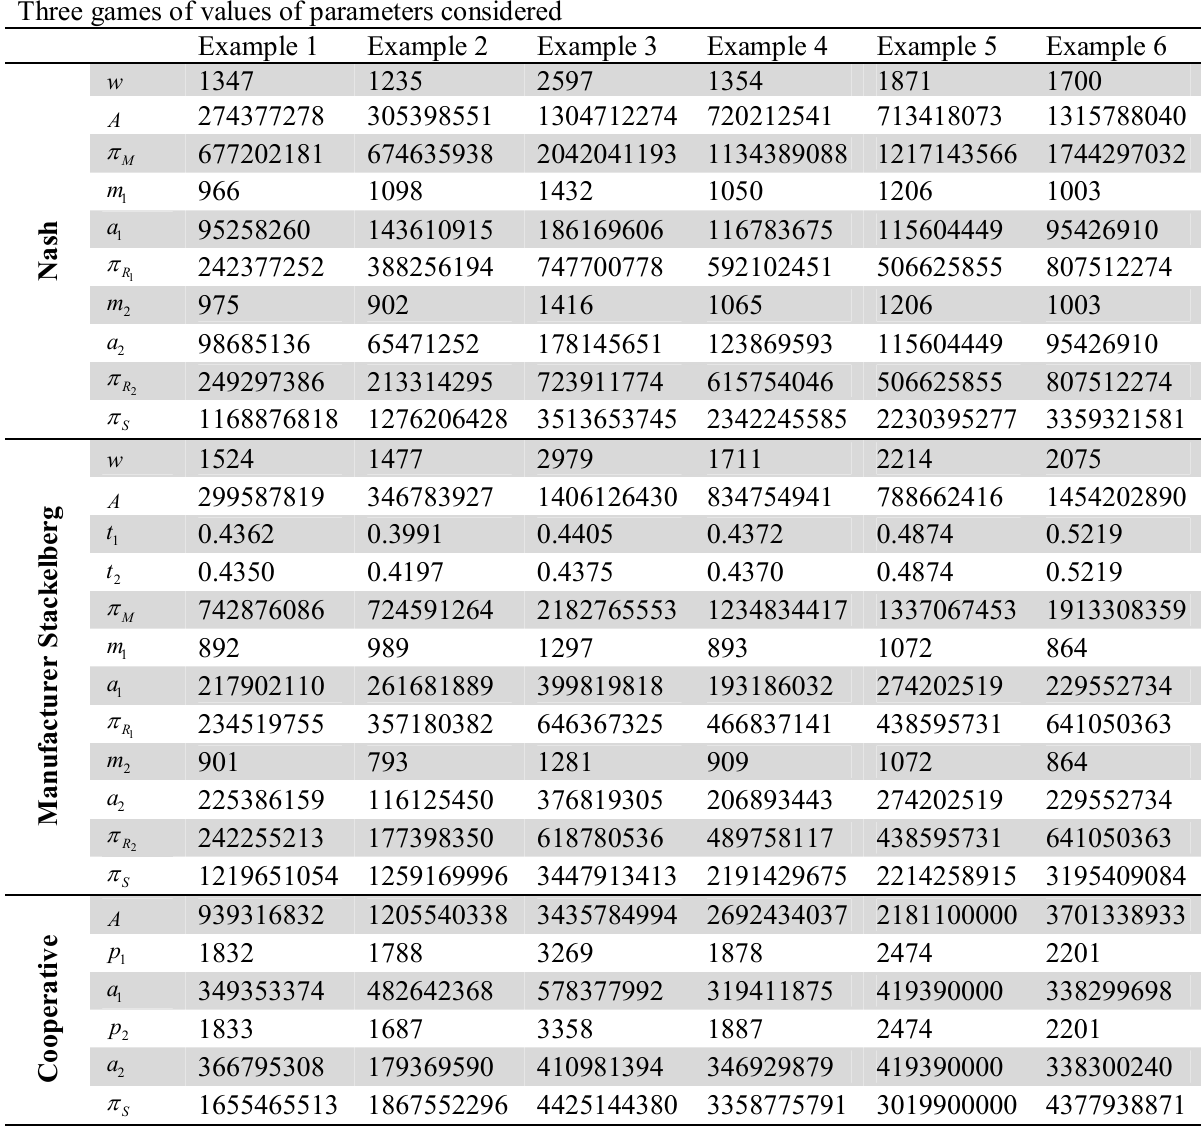
Three games of values of parameters